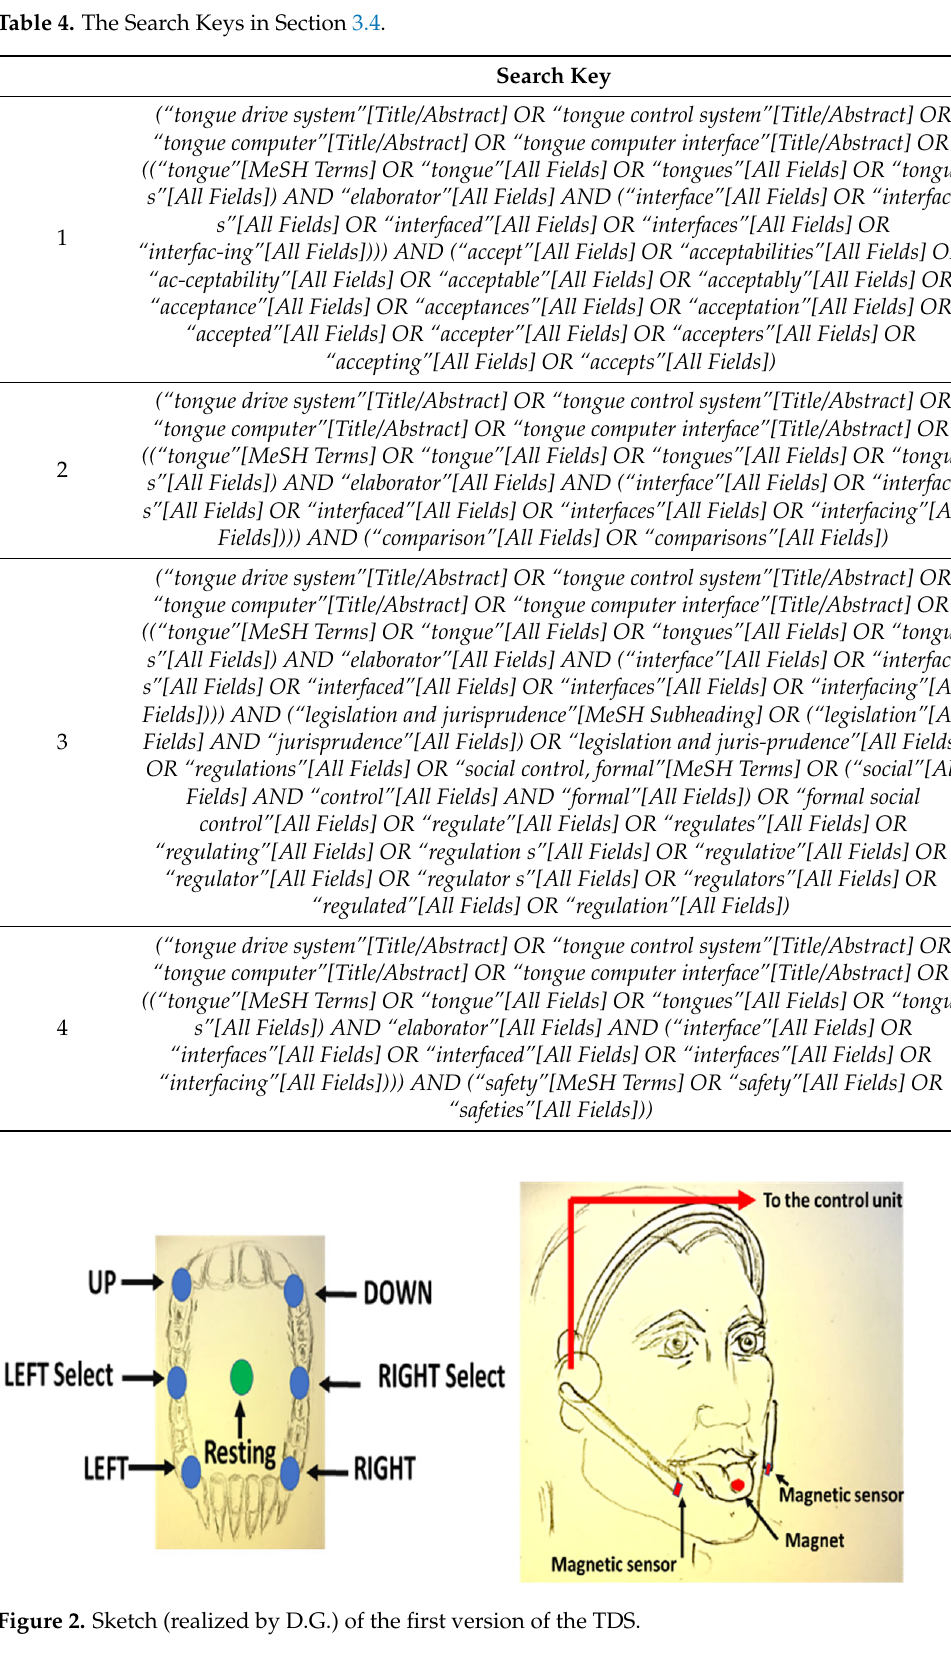
Figure 3. Sketch (realized by D.G.) of the upgrade to the TDS: (A) the introduction of the magnetic piercing; (B) the introduction of the oral control unit.